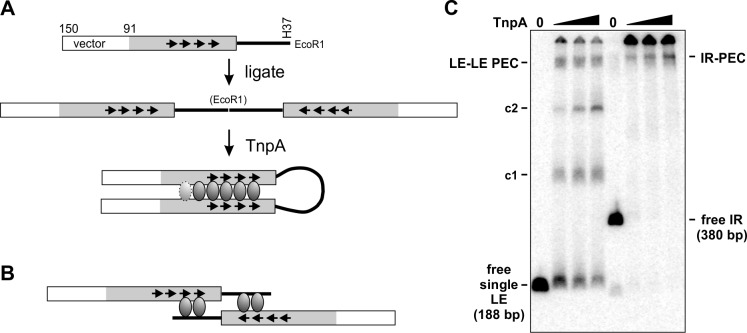
Parallel arrangement of DNA strands within the PEC.(A) An IS1535 substrate was generated by PCR that contains 59 bp of pUC18 fused to 91 bp of LE DNA plus 37 bp of flanking host DNA that terminates at an EcoR1 site. Digestion with EcoR1 and ligation generates a 380 bp product (IR) containing two LEs in an inverted orientation, which was gel purified and then 5′ end-labeled with 32P using polynucleotide kinase and γ-32P-ATP. Incubation of the IR with TnpAIS1535 is predicted to generate a PEC if the LEs align in a parallel manner, as illustrated. An interwrapped parallel configuration of the LEs that allows for a similar looped extension of the intervening host DNA, rather than an elongated structure as schematically pictured, is also compatible with PEC formation. The length of the intervening loop used in the IR substrate in panel C is 80 bp from the LE termini or 116 bp from the primary Exo I digestion stop site next to motif a (Figure 4B E). (B) Schematic representation of a PEC formed on the starting DNA fragment in panel A with LEs synapsed in an antiparallel configuration. This configuration is incompatible with formation of a PEC with the ends of the host DNA covalently joined after ligation. Moreover, footprinting data provide no evidence for TnpA binding to the host DNA as drawn (note that motif d ends at bp 59, whereas only 37 bp of host DNA are present). (C) PEC formation on the IR substrate. The first four lanes were incubation of 0, 8, 16, and 32 nM TnpAIS1535 with the unligated substrate (panel A top) and next four lanes were with the IR substrate. The IR-PEC, which migrates similarly to the LE-LE PEC, provides evidence for a parallel configuration of the LEs (panel A). These reactions were performed with 2% of the standard amount of substrate DNA to favor intramolecular synapsis. Bimolecular products formed on the IR substrate may be present in the wells.